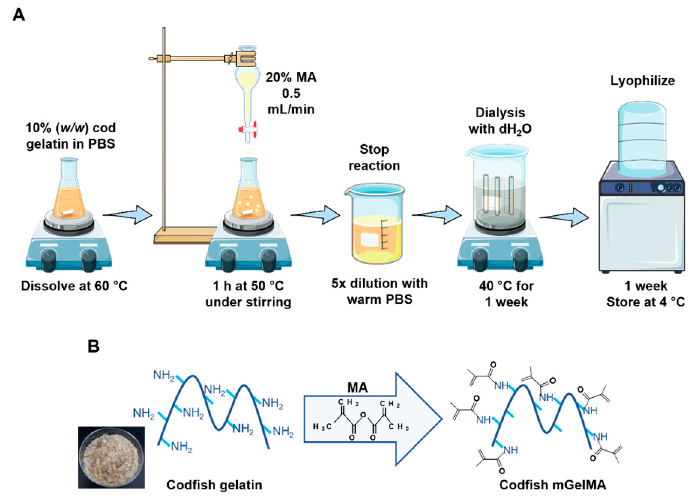
Figure 1. Overview of the mGelMA production process. ( A ) Schematic illustration of the mGelMA production. After gelatin dissolution, the MA (methacrylic anhydride) was added very slowly under stirring and allowed to react for 1 h at 50 ◦ C. The reaction was stopped by diluting the resulting product with warm (40 ◦ C) PBS and dialyzed against water for approximately 1 week. After lyophilization, codfish mGelMA was stored at 4 ◦ C. ( B ) Scheme of the codfish gelatin reaction with MA to generate codfish